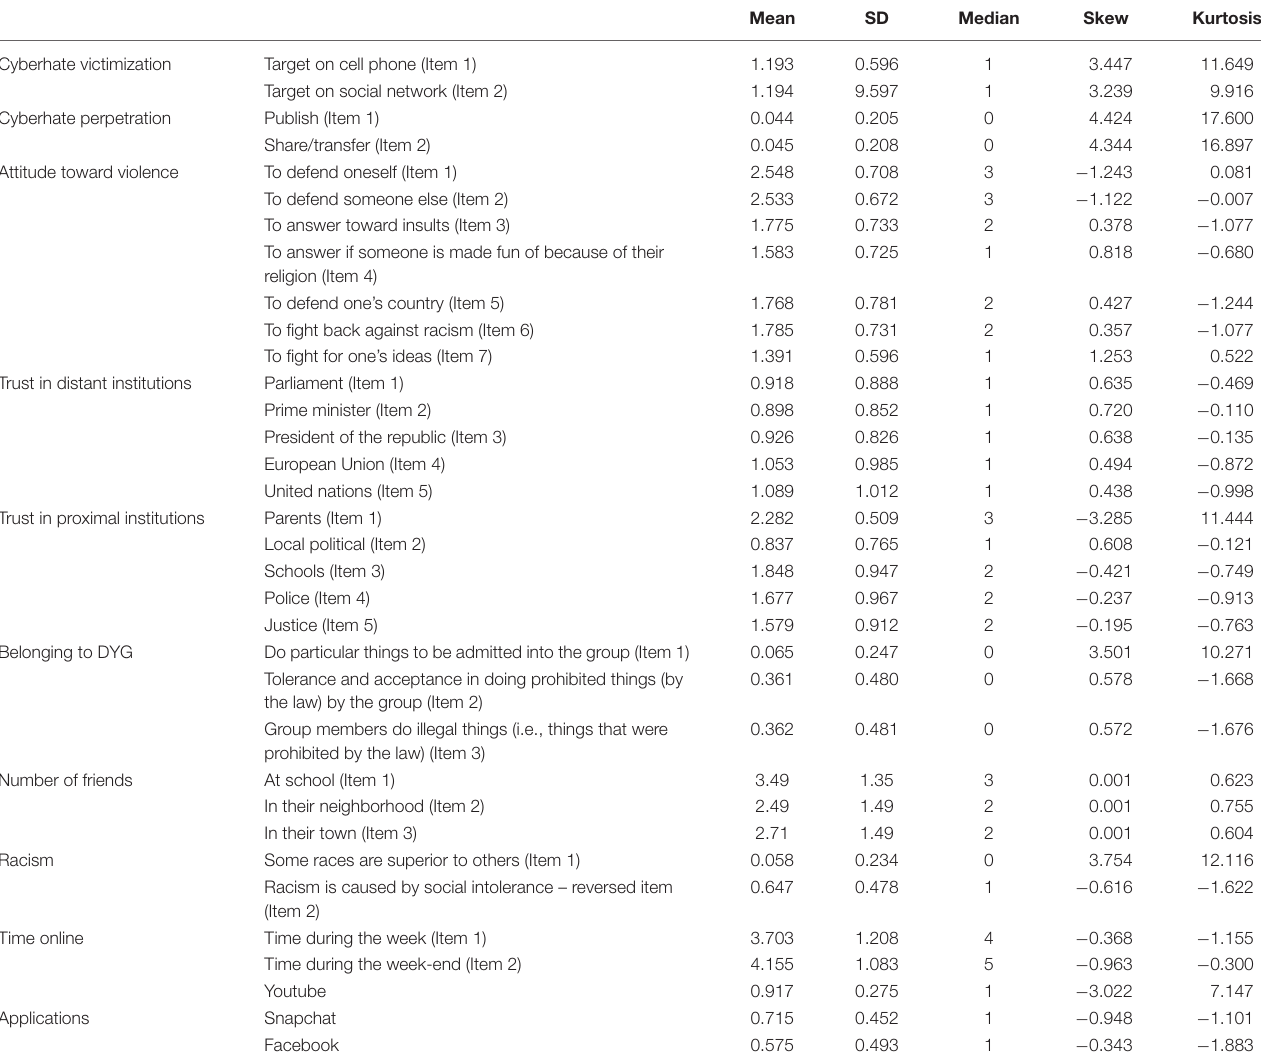
TABLE 4 | Descriptive statistics for the items included in the SEM analysis.